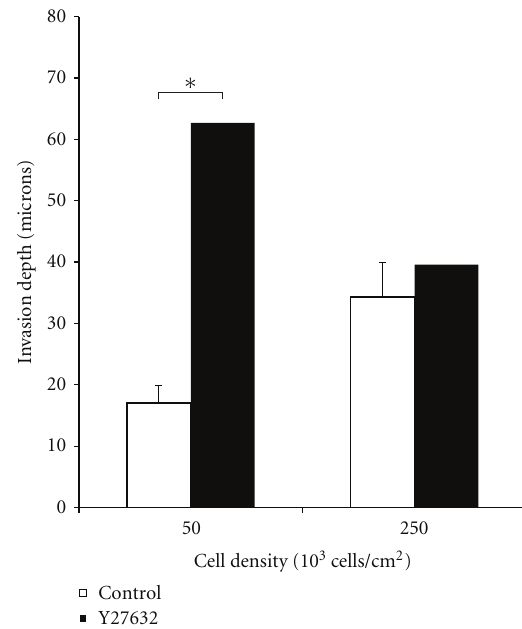
Figure 4: SW620 cells were seeded at densities of 50 × 10 3 and 250 × 10 3 cells/cm 2 onto 1.5mg/mL collagen I gels. Sca ff olds were treated with Y-27632 to study the impact of ROCK inhibition on cell invasion in a low- and high-density environment. Treatment with Y-27632 resulted in a 3.5-fold increase in cell invasion for cells seeded at 50 × 10 3 cells/cm 2